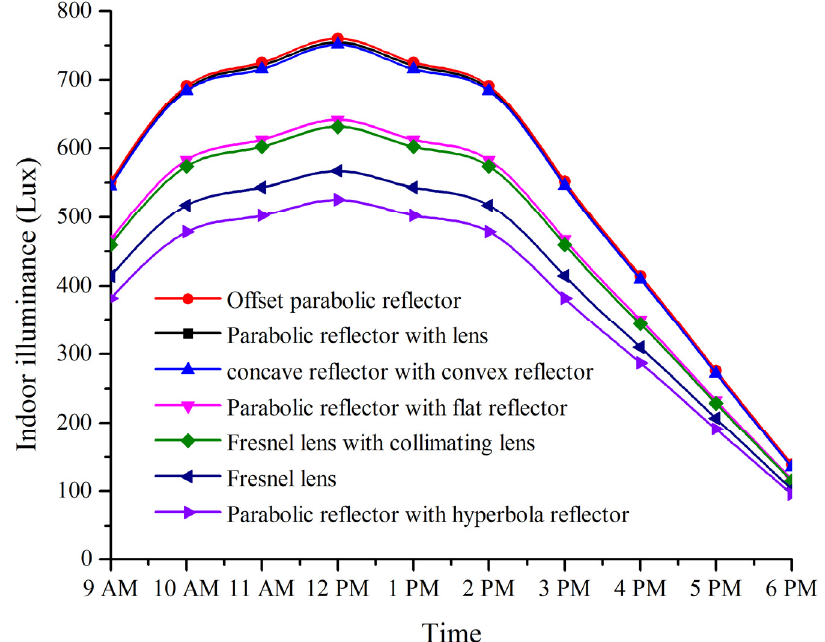
Figure 9. Indoor illuminance on the working plane at different times of the day using different daylighting